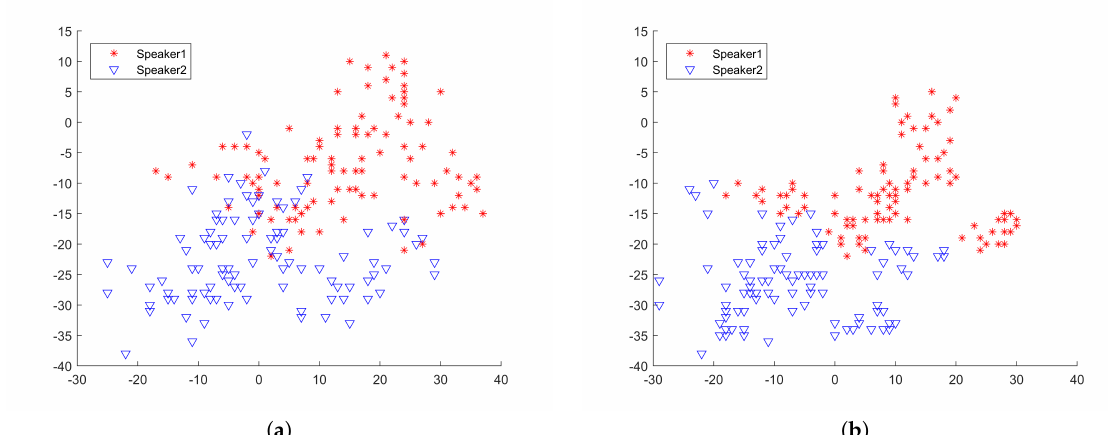
Figure 2. The t-SNE visualization of the speaker class distribution of the first conversation data. On each sub-figure, we visualize 100-feature vectors (generated randomly). ( a ) denote the class distribution for standard i-vector while ( b ) shows the class distribution for EVA-based